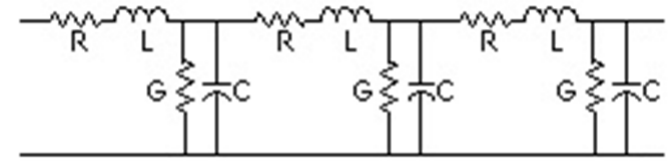
Figure 4. Transmission line structure